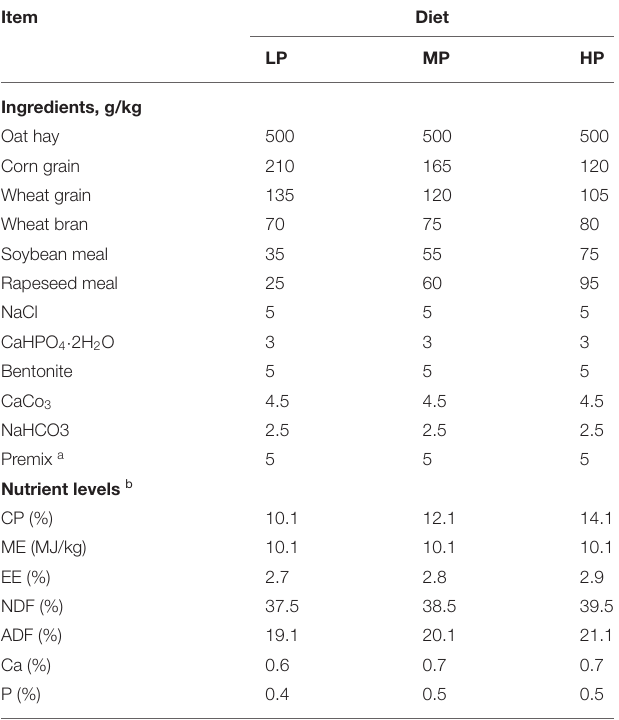
TABLE 1 | Ingredients and nutrient levels of the experimental diets with three different protein levels (on a dry matter